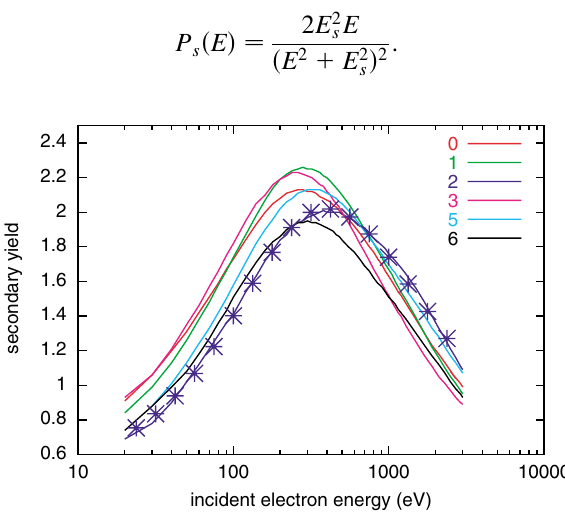
FIG. 5. (Color) Secondary emission yield for titanium nitride- coated stainless steel from identically manufactured samples. The samples were manufactured by the BNL vacuum group under the direction of Hseuh. The measurements were per- formed by Henrist of the CERN vacuum group. The surfaces have not been baked or conditioned in any way. The solid lines are data and the markers are a fit of Eq. (4) to the blue curve. Of all the fits, the one shown had the largest rms deviation from the data,